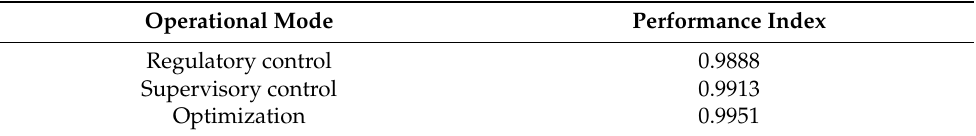
Table 9. Performance index for each operational